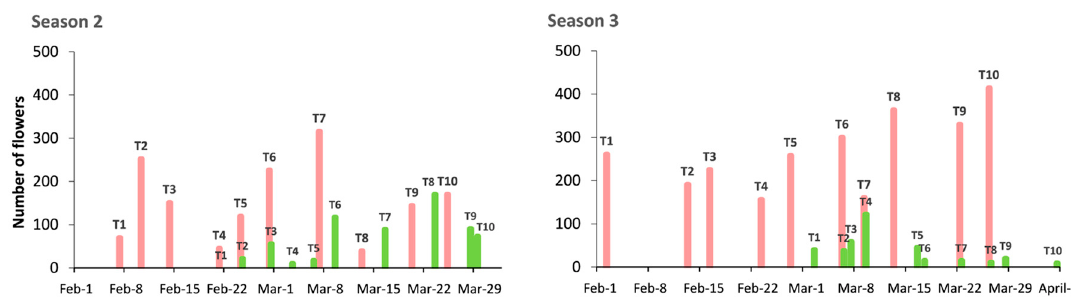
Figure 4. Flowering time and number of flowers pollinated of the Desmayo Largueta (pink) and Tardona (green) for T1–T10 treatments during Seasons 2 and 3.